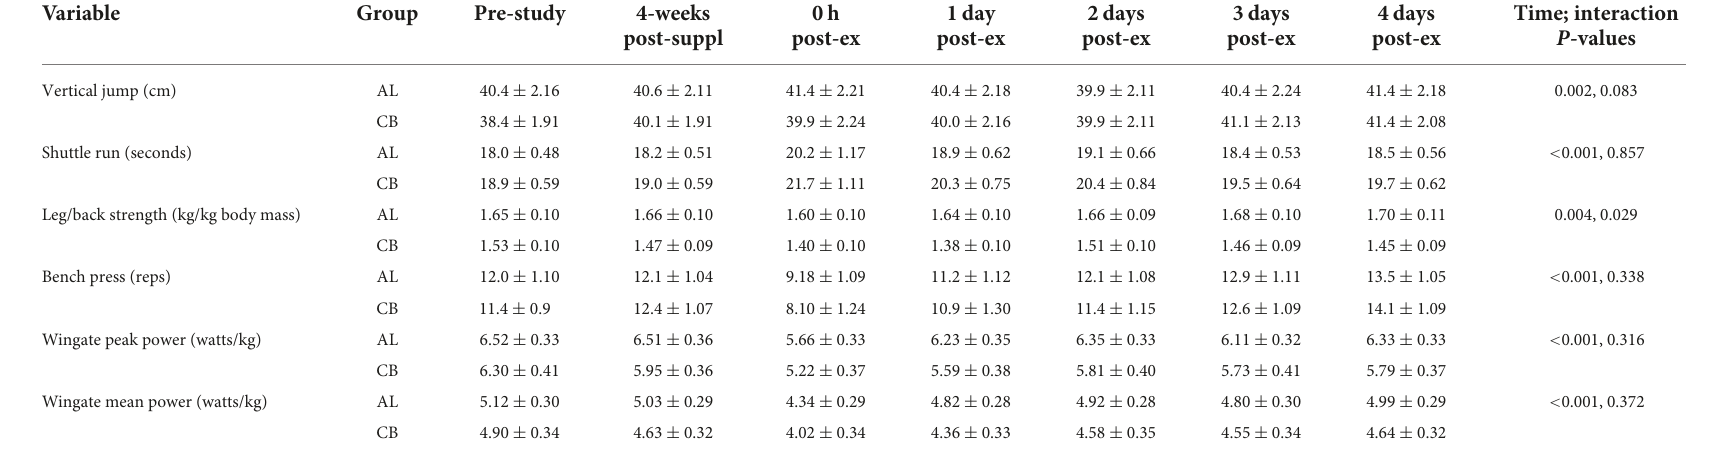
TABLE 3 Performance data before and after 4-weeks supplementation, and immediately post 90 min eccentric exercise and in an overnight fasted state during 4 days of recovery (AL = almond, n = 33; CB = cereal bar, n = 31) (means ± SE).